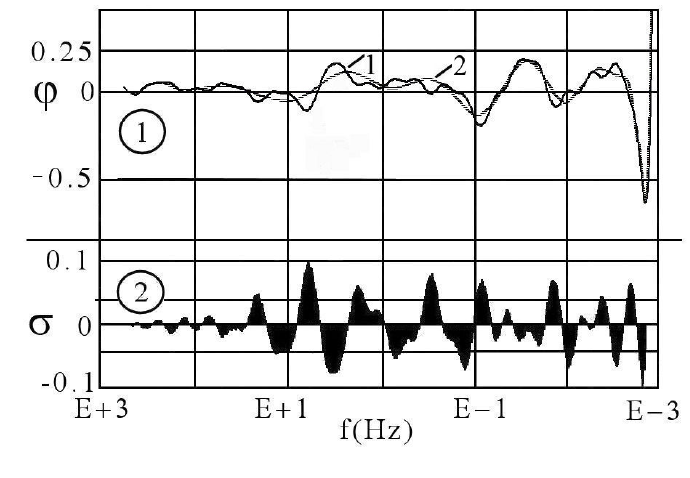
Figure 29. Fourier series polynomial. Envelope of autocorrelation function at equilibrium potential. Graph( 1 ): autocorrelation function ϕ , 1: variation of experimental curve (full line); 2: variation of computed model (dashed line); graph( 2 ): residual deviation σ